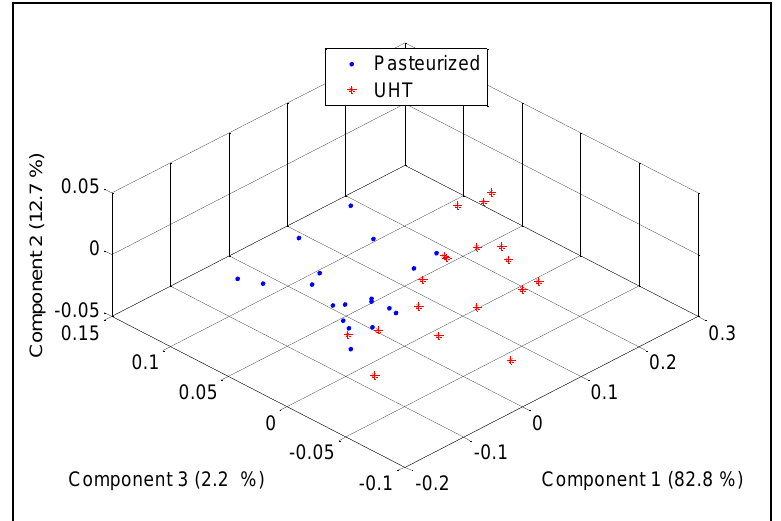
Figure 17. PCA plot for TGS8XX